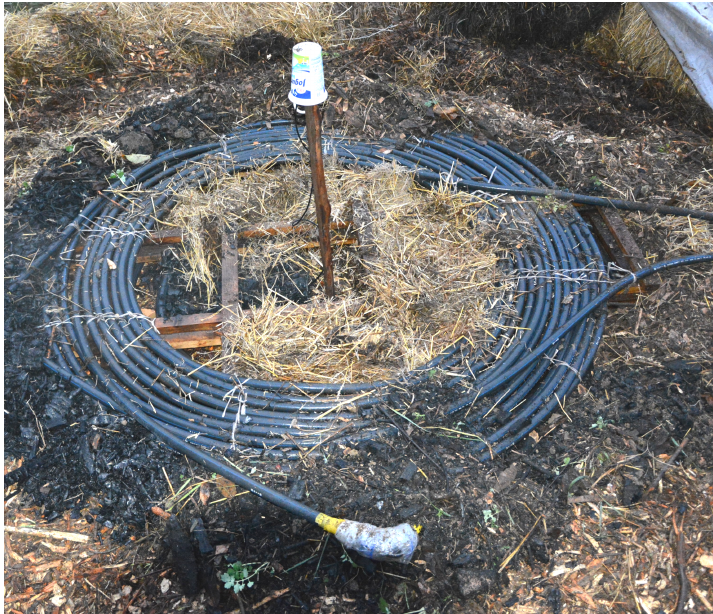
Figure 5. The heat exchanger is gradually covered with porous materials. Note that the cavity is formed underneath the piping, allowing condensation to happen. The temperature sensor for a compost core is installed inside the yellow tube while still uncovered. The wire is hidden under the white